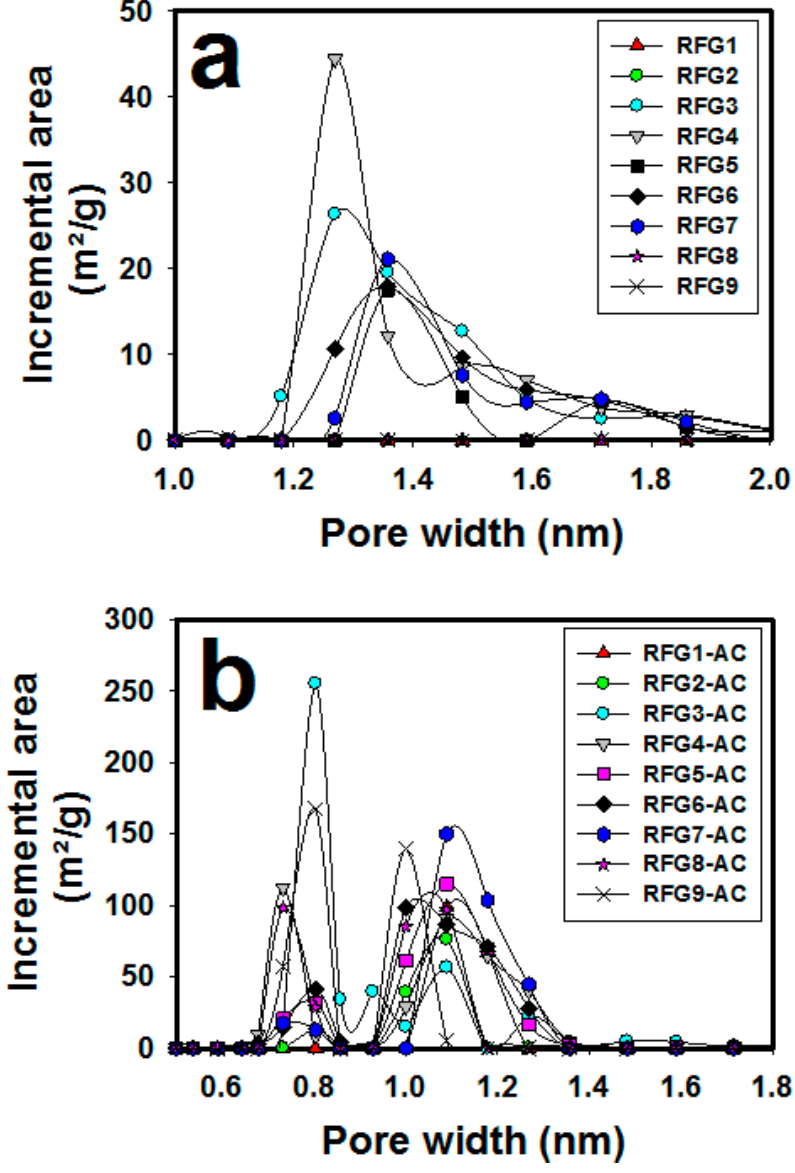
Figure 7. Incremental pore area versus pore width of ( a ) RFG n and ( b ) RFG n -AC samples. It can be observed from Figure 7a that each of the samples RFG3 through RFG7 ex- hibit two main peaks, whereas the samples RFG1, RFG2, RFG8 and RFG9 are relatively nonporous. RFG3 and RFG4 exhibit two key peaks at 1.3 and 1.5 nm. The corresponding incremental pore areas of these two peaks were, respectively, 27.01 and 12.70 m 2 /g (for RFG3) and 44.42 and 8.77 m 2 /g (for RFG4). RG5, RFG6 and RFG7 expose two key peaks at 1.4 and 1.7 nm. The corresponding incremental pore areas of RG5, RFG6 and RFG7 at 1.4 nm are 18.16, 17.86 and 21.40 m 2 /g, respectively; whereas, those at 1.7 nm are 3.77, 4.66 and 5.13 m 2 /g, respectively. The samples of RFG1, RFG2, RFG8 and RFG9 exhibited nil incremental pore areas of less than 1 m 2 /g. Overall, RFG4 denotes the highest incremental pore area; whereas RFG1, RFG2, RFG8 and RFG9 exhibited the lowest incremental pore